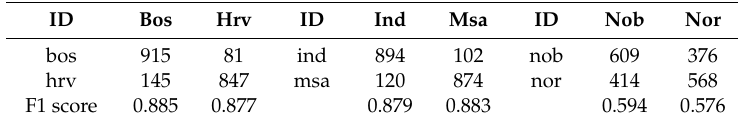
Table 23. Confusion matrix between similar languages in LI in LG.